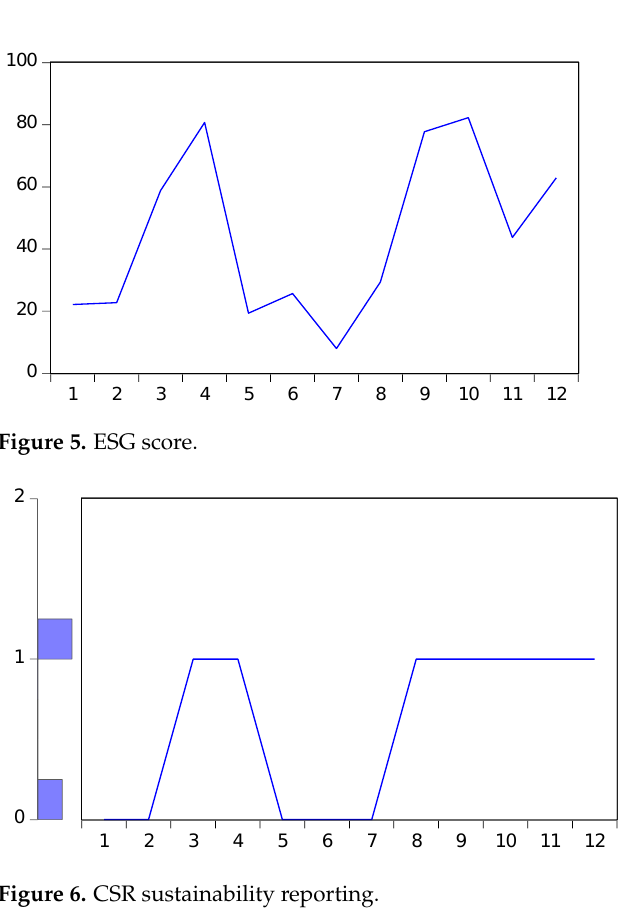
Figure 6. CSR sustainability reporting.